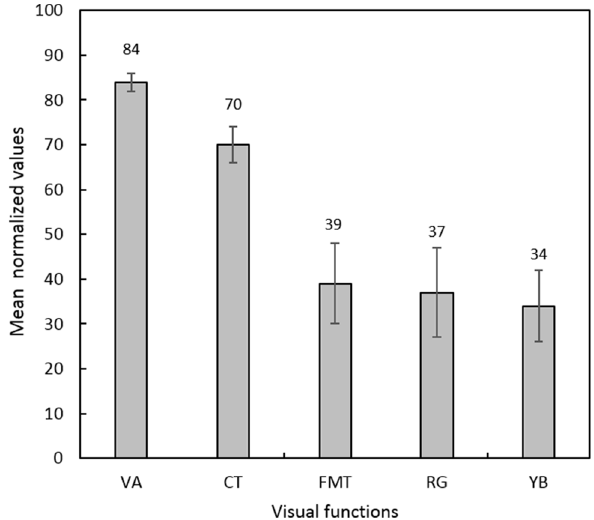
Figure 5. Bar diagram showing mean normalised visual functions (with SEM) in comparison to respective age- matched normative values. Visual acuity (VA), contrast threshold (CT), flicker modulation threshold (FMT), red/green (RG) and yellow/blue (YB) sensitivities are normalised with their respective age-matched values. 100% refers to equal to age-matched normative values. The error bars represent the standard error of the